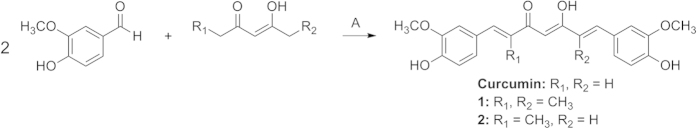
Synthesis of curcumin, 1, and 2.Reagents and conditions: (A) B2O3, ethyl acetate, (n-BuO)3B, n-BuNH2, 80 °C, 140 min; 1 N HCl, 50 °C, 30 min.